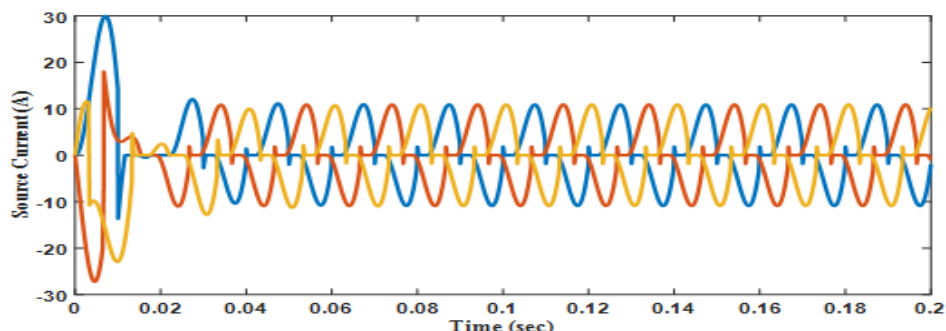
Figure 7. Source Current Waveforms.